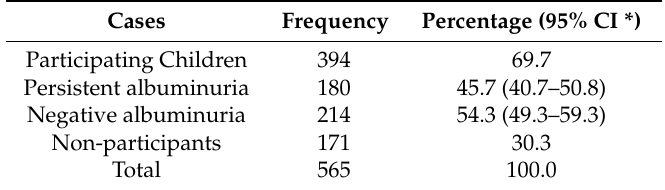
Table 1. Frequencies of albuminuria in children studied in the community of Agua Caliente, Jalisco. Cases Frequency Percentage (95% CI *) Participating Children